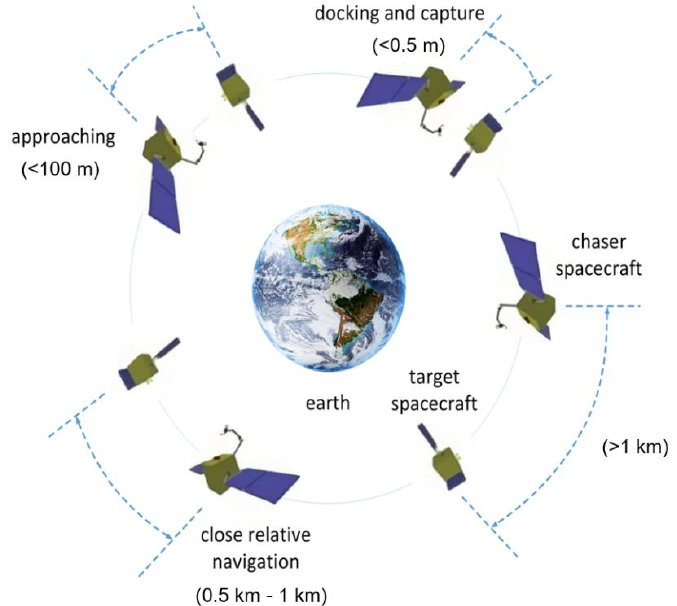
Figure 1. Typical non-cooperative spacecraft on-orbit service mission.